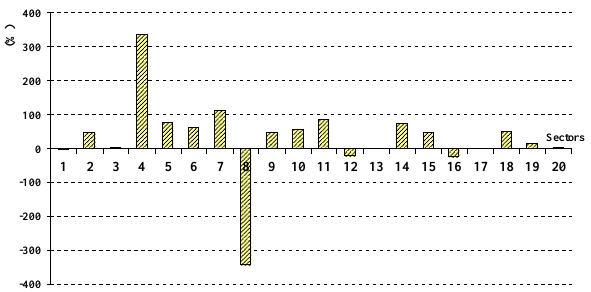
Figure 2. Ratios of net virtual water export to water use for domestic final demand in Fig. 2. Ratios of net virtual water export to water use for domestic different sectors (2002) final demand in different sectors (2002).